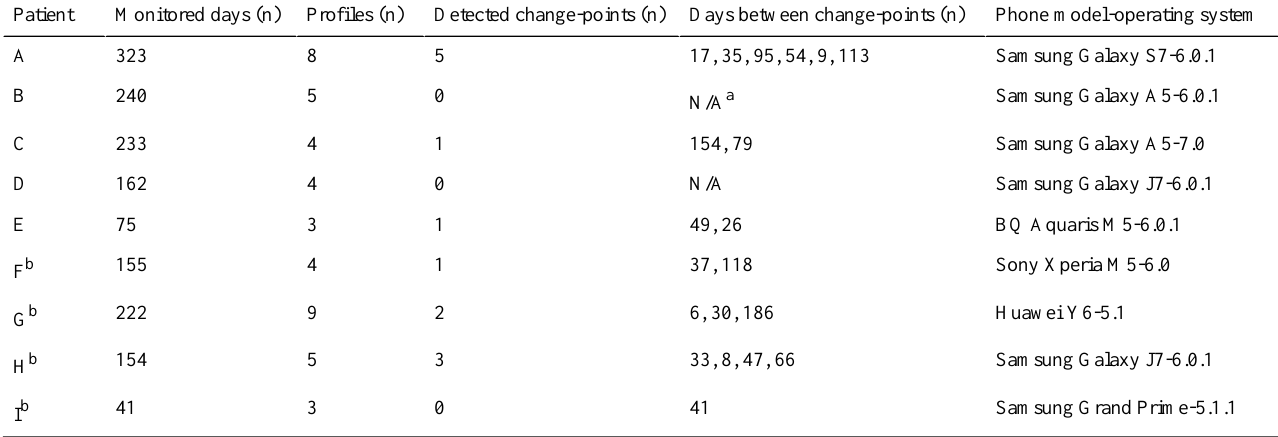
Table 1. Statistics of patients addressed for